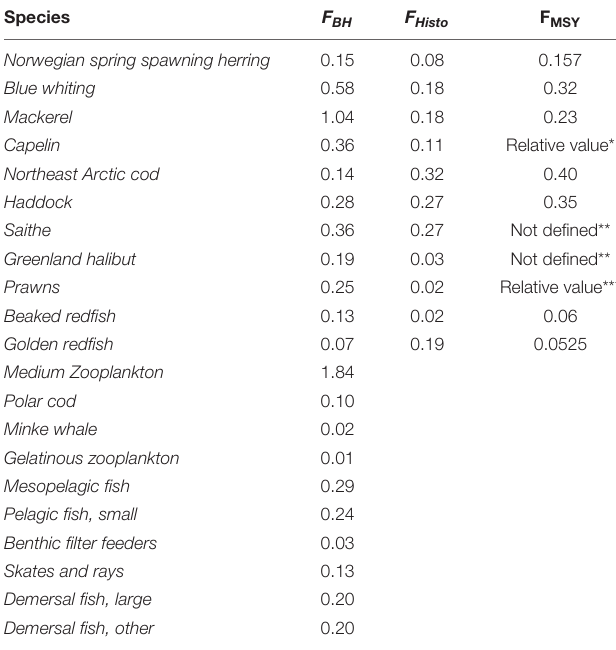
TABLE 4 | Mean fishing mortalities ( F BH ) of 25% of the estimated productivity for all species in the